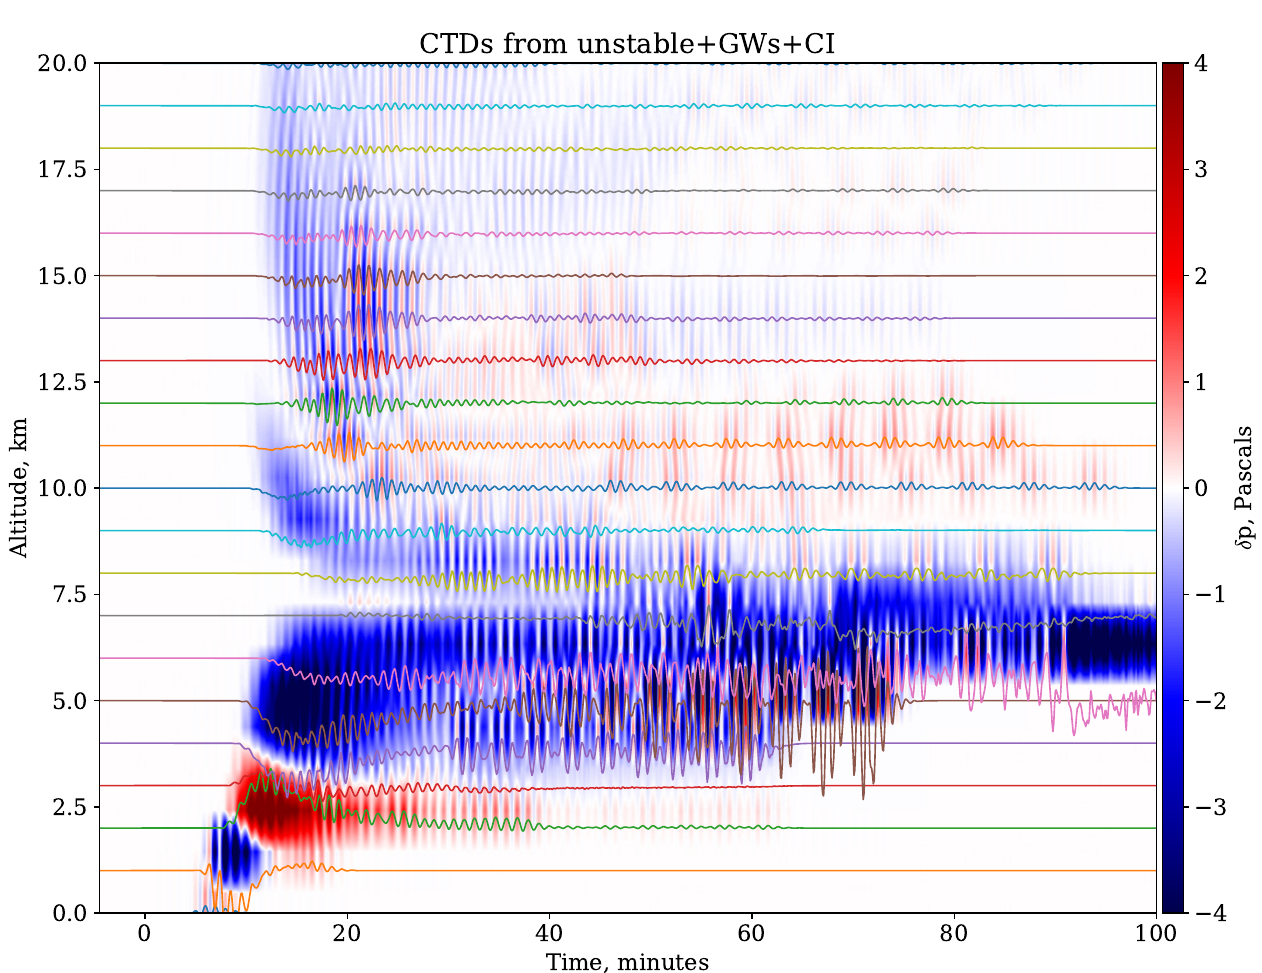
Figure 6. Vertical Travel Time diagram above the epicenter: it shows the CTDs from the unstable GWs+CI case. CTDs defined as expression (6) is plotted in two types of format: as line plot at each height and as color pixmap. For better visualization, CTDs in line plot is multiplied by factor